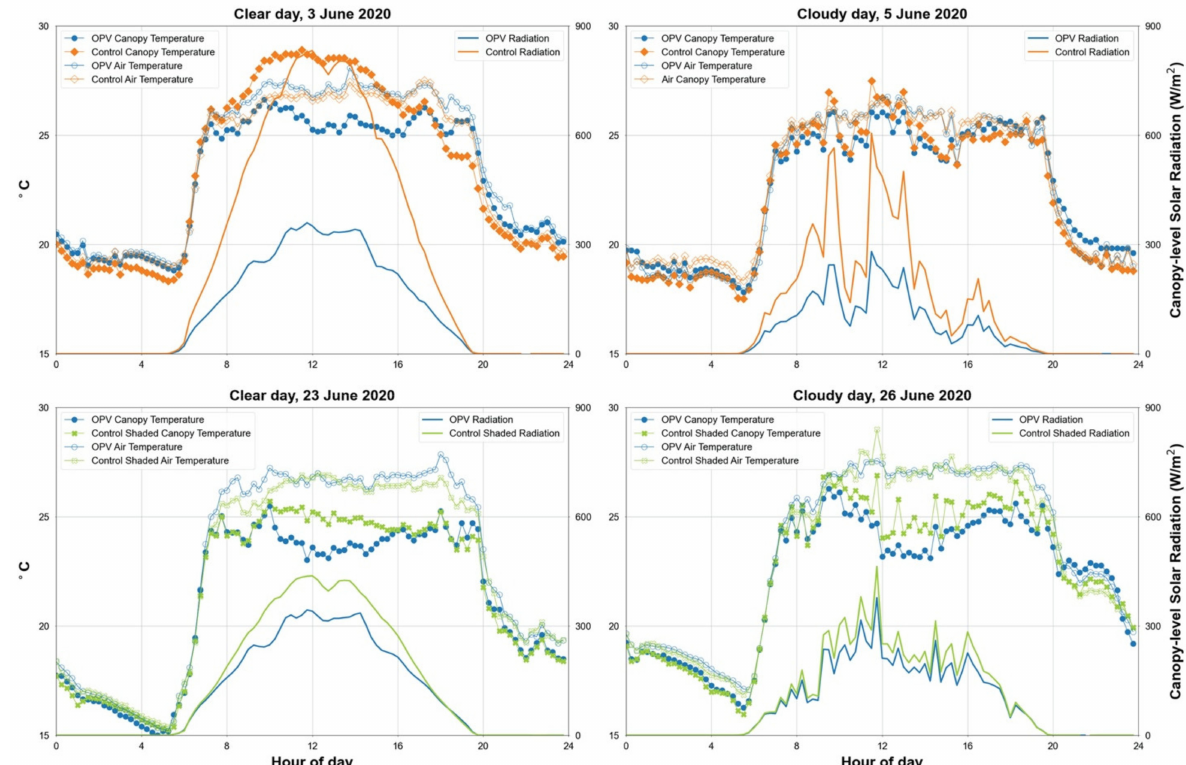
Figure 6. Canopy temperature, air temperature, and canopy-level solar radiation in the OPV and Control sections, comparing conditions in clear ( left ) and cloudy ( right ) sky conditions, and the Control section when it was unshaded ( top ) and when it was shaded by the 30% shade net ( bottom ).